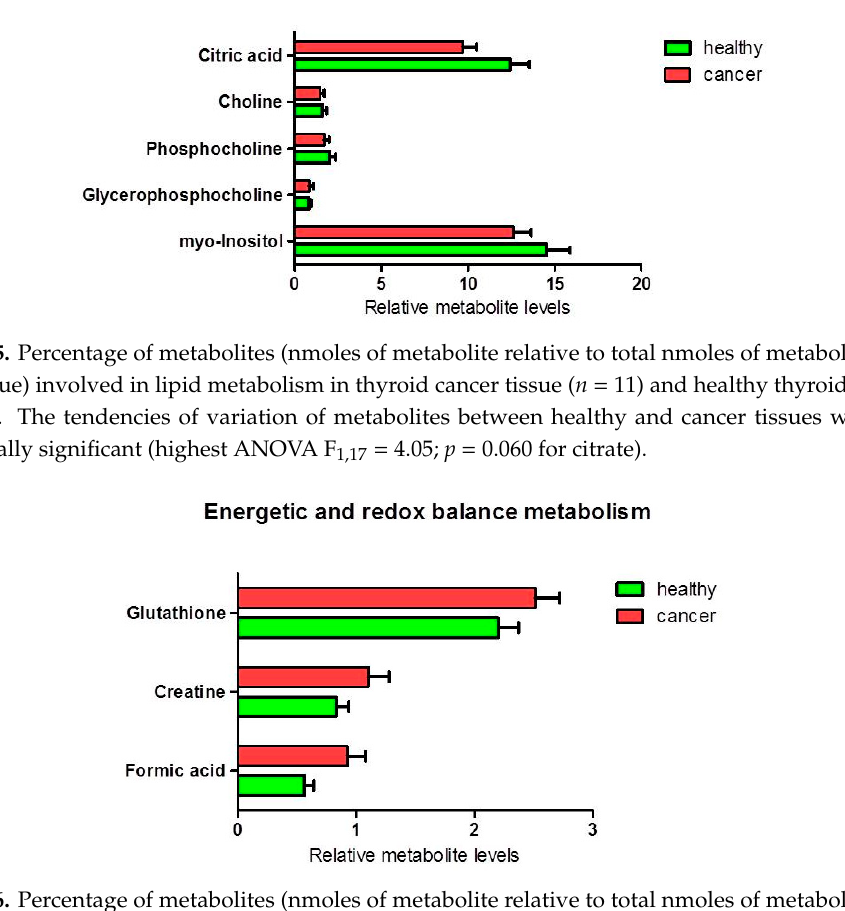
Figure 6. Percentage of metabolites (nmoles of metabolite relative to total nmoles of metabolites per g of tissue) involved in energy and redox balance in thyroid cancer tissue ( n = 11) and healthy thyroid tissues ( n = 10). The tendencies of variation of metabolite % between healthy and cancer tissues were not statistically significant (ANOVA p > 0.05).